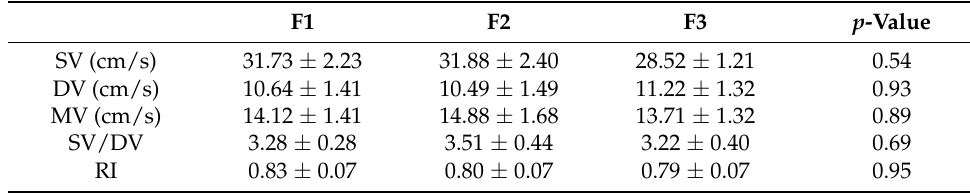
Table 4. Effect of ejaculate fraction (F1, F2, or F3) on Doppler ultrasonography values of the uterine arteries blood flow. Data include the statistical analysis of repeated measures (D0, D1, and D5). Data are shown as the mean ±